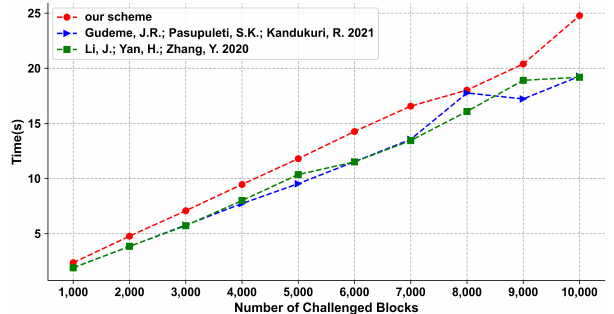
Figure 6. Computation cost of ProofVerify